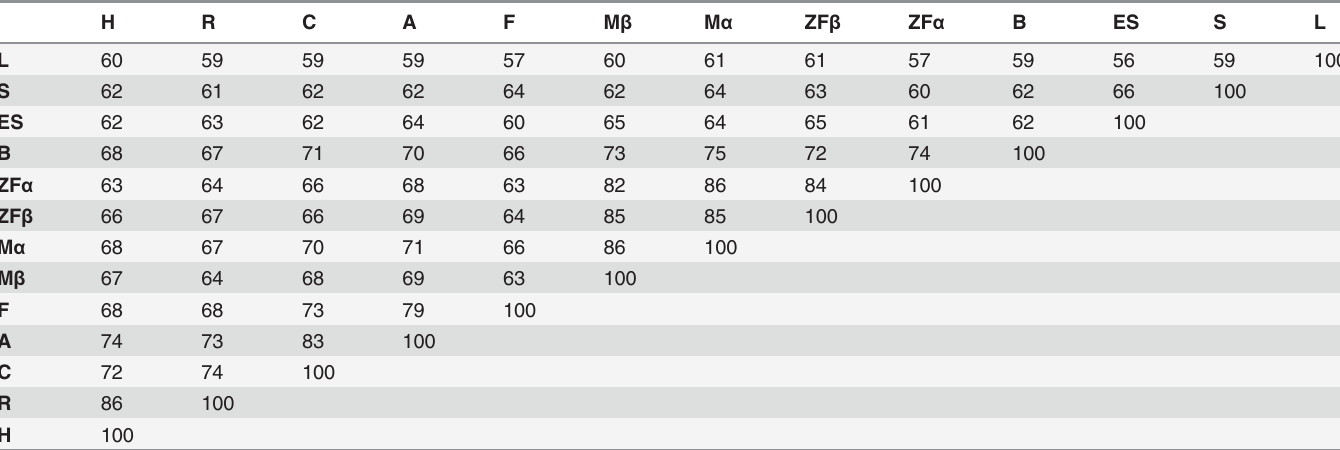
Table 2. Homology of vertebrate VDR ligand-binding domains (LBDs).